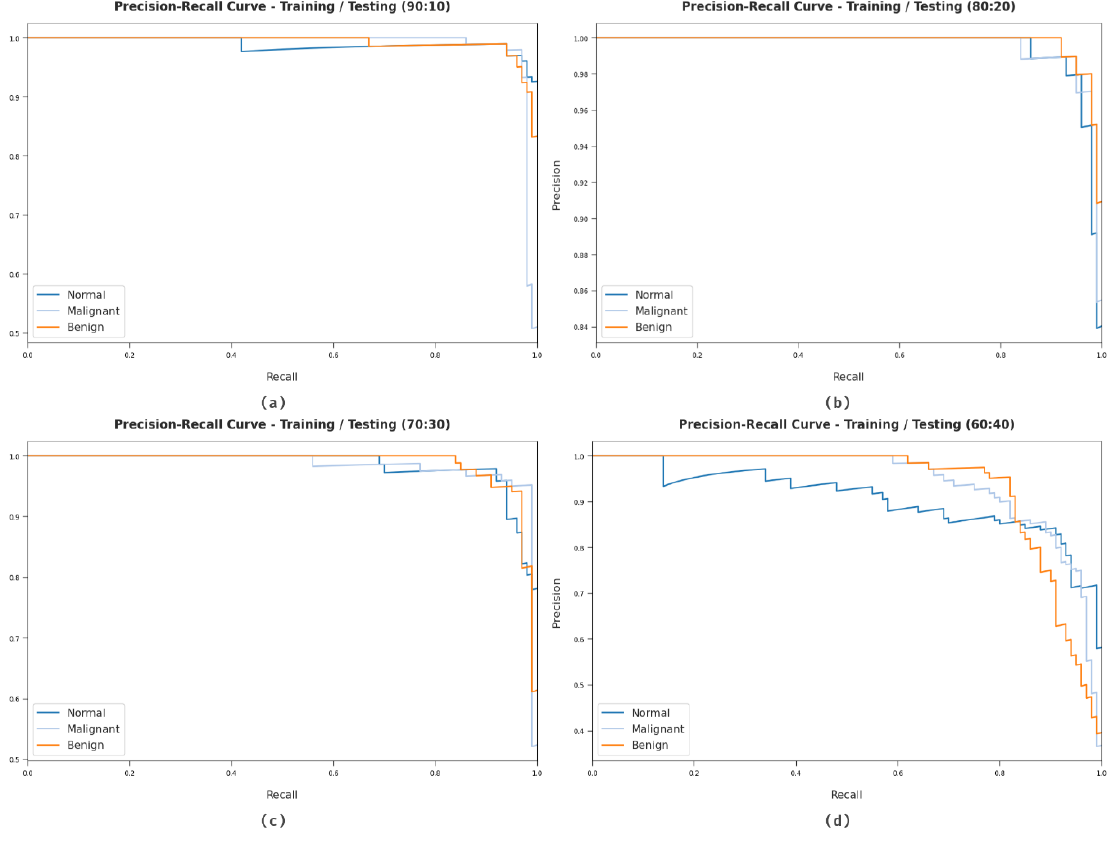
Figure 7. Precision – recall analysis results of the CSO-CADLCC technique under distinct TR/TS data. ( a ) TR/TS data of 90:10, ( b ) TR/TS data of 80:20, ( c ) TR/TS data of 70:30, and ( d ) TR/TS data of 60:40 Table 2. Comparative analysis between the CSO-CADLCC technique and other recent algorithms. Methods